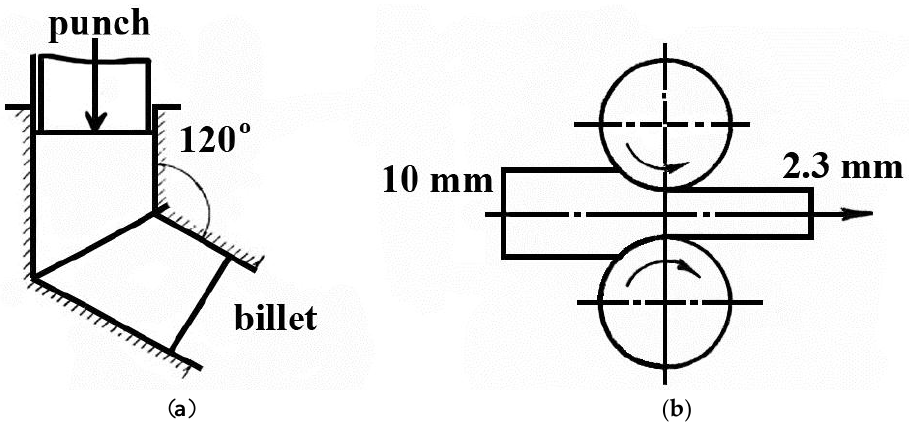
Figure 1. The principle of the combined processing of the steel ( a ) Stage I—ECAP, ( b ) Stage II—Rolling